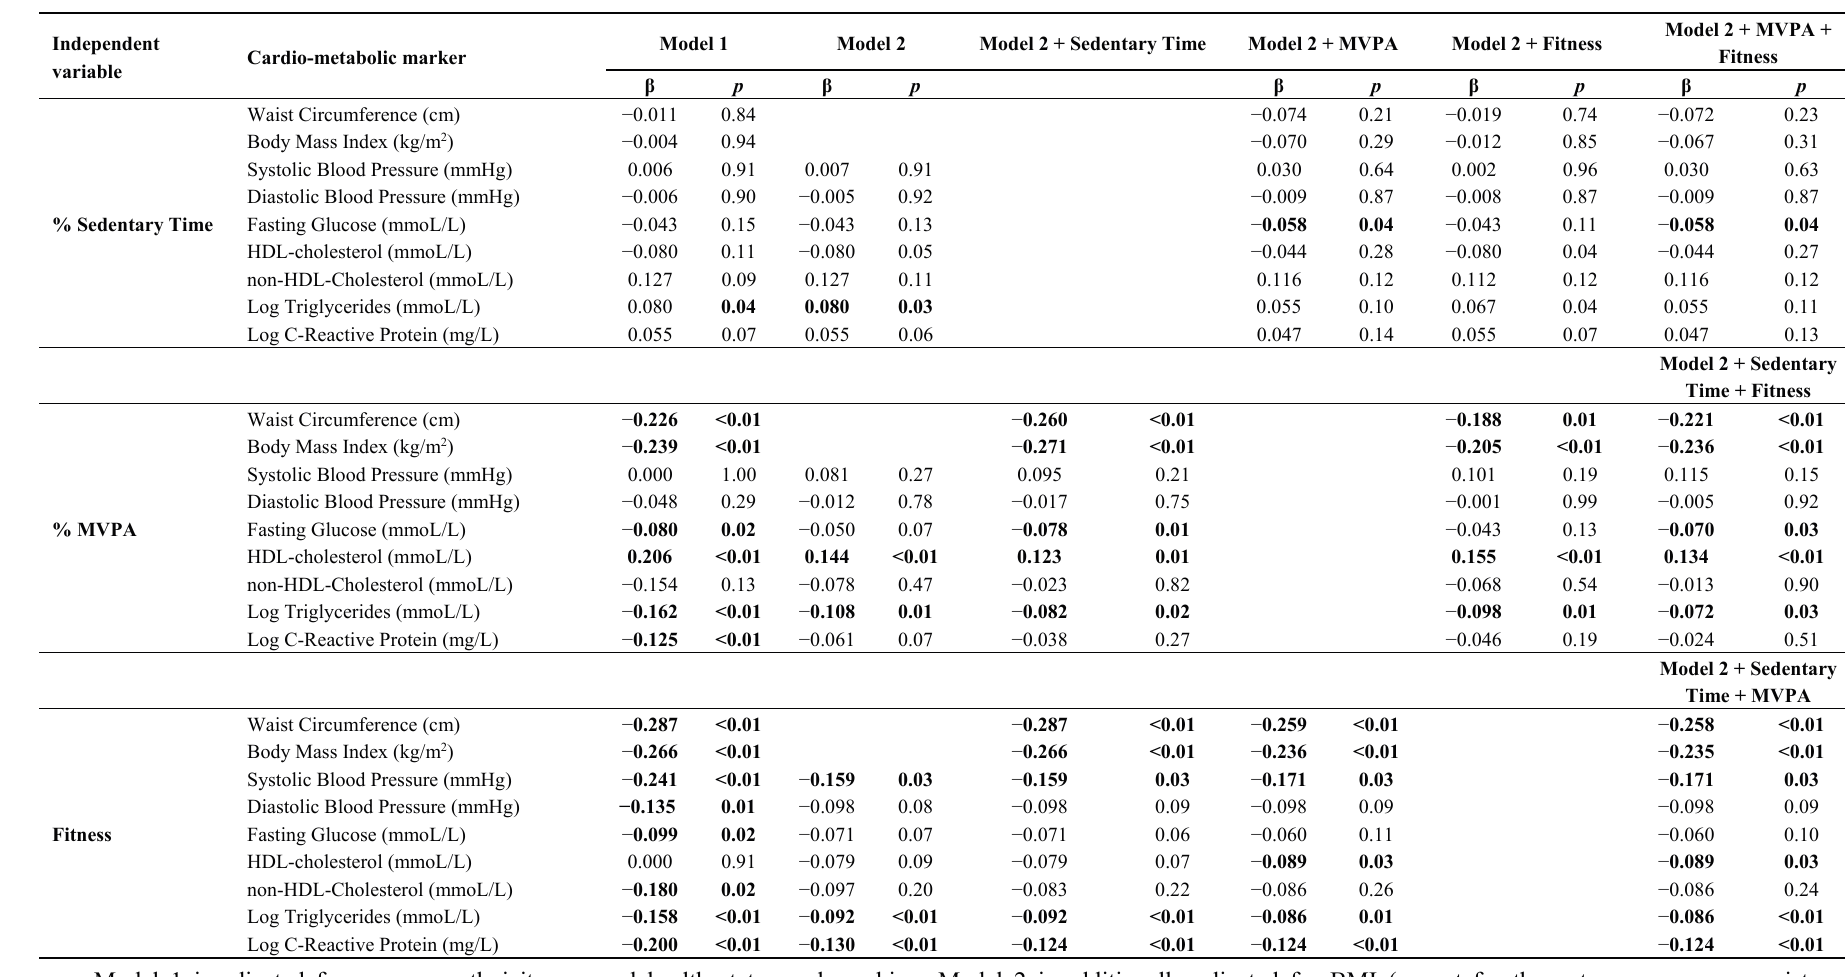
Table 3. Standardized regression coefficients ( β ) of cardio-metabolic markers according to percent sedentary time, MVPA and fitness. Independent Cardio-metabolic variable